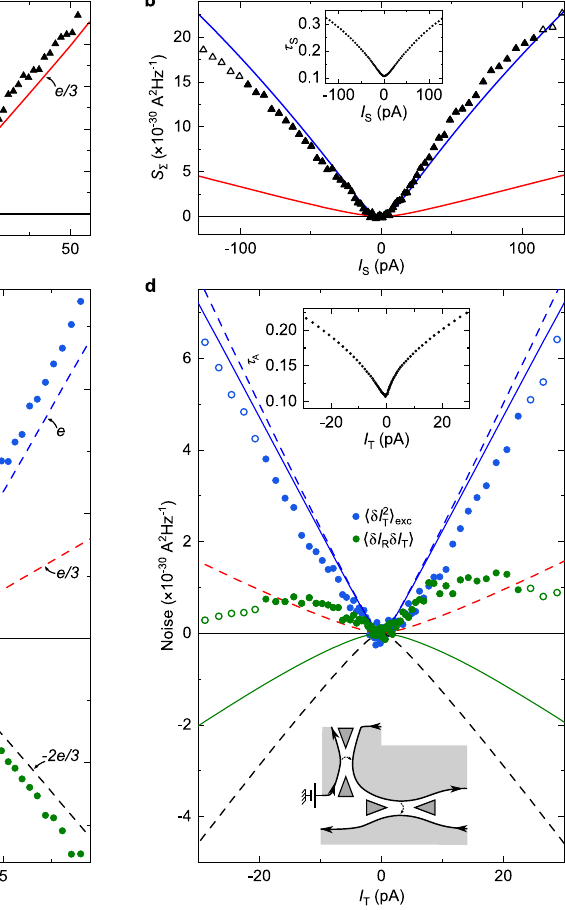
Fig. 3 | Noise observation of Andreev re fl ection. a, b Simultaneous character- ization of the source set in the WBS ( a ) or SBS ( b ) regime (see illustrative bottom inset in ( c ) or ( d ), respectively). Continuous blue and red lines represent the shot noisepredictionsofEq.(1)fortunnelingsofcharge e and e /3,respectively,usingthe measured transmission ratio τ S across the source QPC (inset) and T =35 mK. Symbols display measurements of S Σ , corresponding to the shot noise across the source. c, d Transport mechanism across the analyzer with incident fractional quasiparticles ( c , using the WBS source shown in ( a )) or incident quasielectrons ( d ,usingtheSBSsourceshownin( b )).Thesimultaneousmeasurementsof τ A ≲ 0.2 are shown in the respective top insets (note the higher noise at low I T due to the